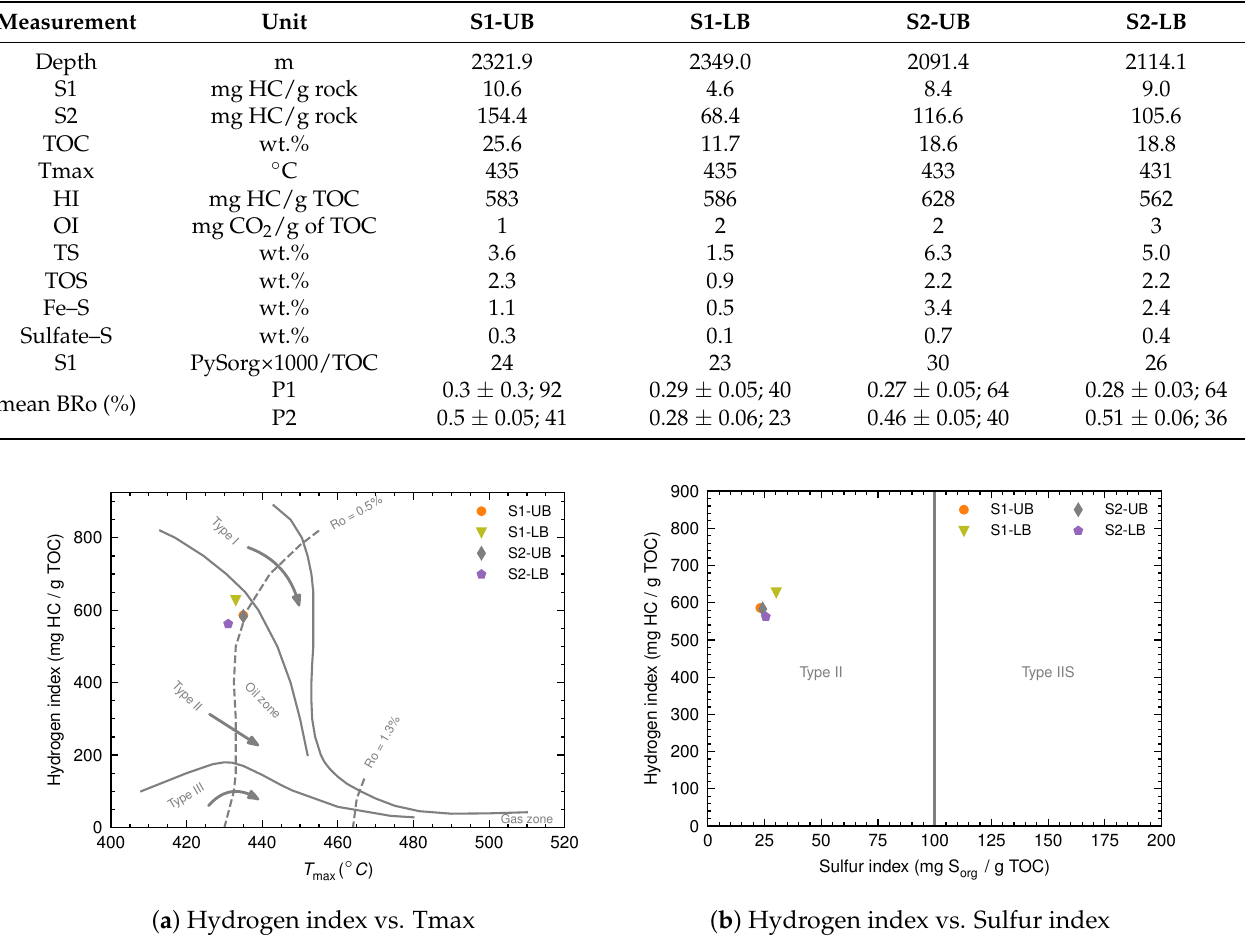
Figure 2. The kerogen type and maturity from the programmed pyrolysis data. The data suggested a type II kerogen in the immature to early oil